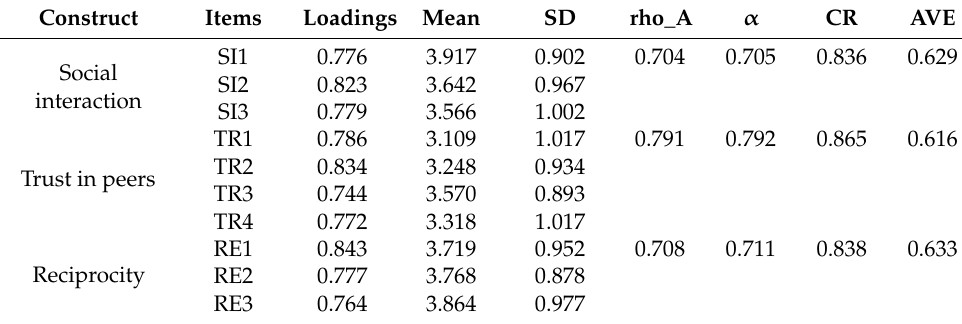
Table 1. Construct reliability and